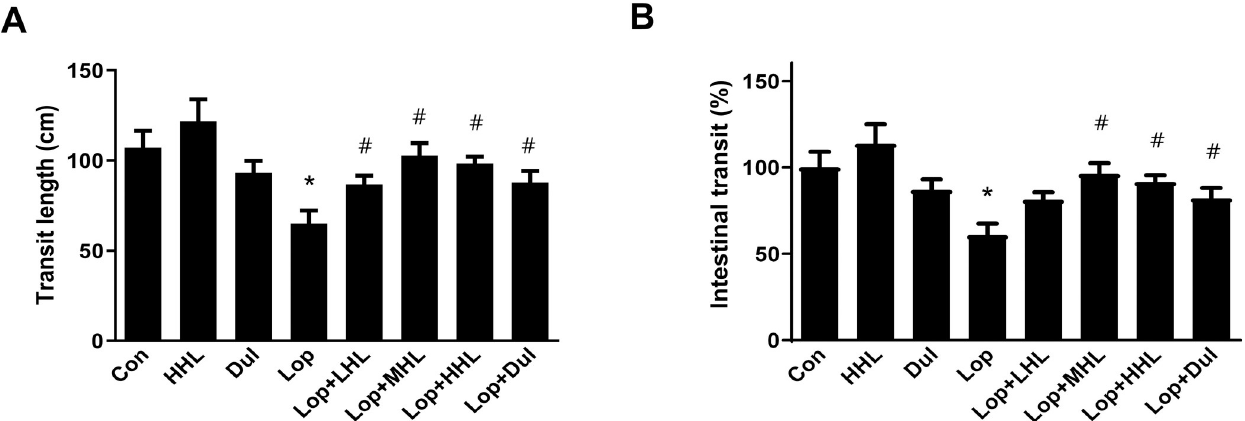
Fig 2. Effects of HLp-nF1 on a small intestinal transit parameter in a loperamide-induced constipation rat model. Eight-week-old male rats were treated with loperamide along with 3.2 × 10 10 , 8 × 10 10 , and 1.6 × 10 11 cells/mLHLp-nF1, and Dulcolax, individually. A single treatment with 1.6 × 10 11 cells/ mLHLp-nF1 or Dulcolax was used as the control group. The intestinal transit length ( A ) and intestinal transit percentage ( B ) were measured and quantified as described in the Materials and Methods. The quantification analysis is shown. Data represent the mean ± SD. A t-test was used to determine the means of two groups ( n = 7 ). � P < 0.05 vs. control group, # P < 0.05 vs. loperamide-treated group. Con , control group; Lop , loperamide-treated group; Dul , Dulcolax- treated group (0.75 mg/kg); HHL , treatment with 1.6 × 10 11 cells/mL HLp-nF1; Lop+LHL , treatment with loperamide and 3.2 × 10 10 cells/mL HLp-nF1; Lop +MHL , treatment with loperamide and 8 × 10 10 cells/mL HLp-nF1; Lop+HHL , treatment with loperamide and 1.6 × 10 11 cells/mL HLp-nF1; Lop+Dul treated group.